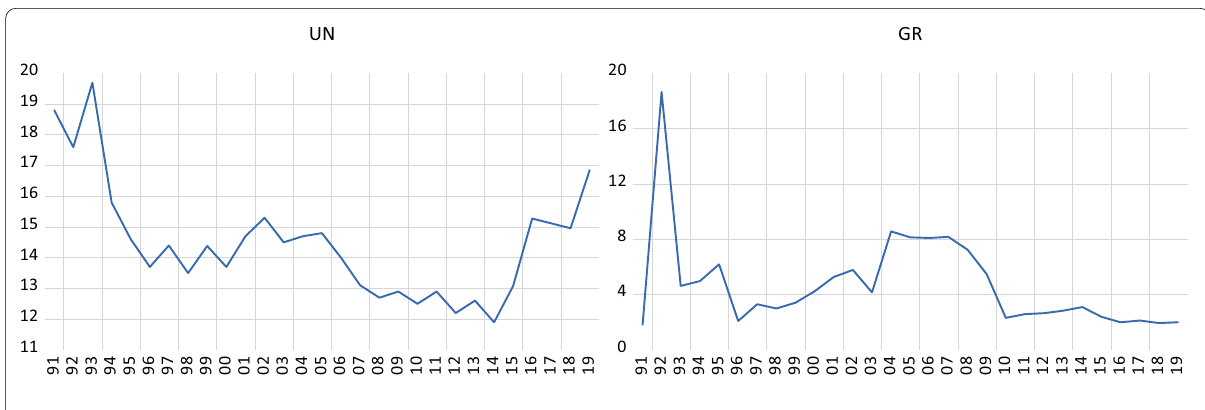
Fig. 1 Unemployment rate and GDP growth in Jordan for